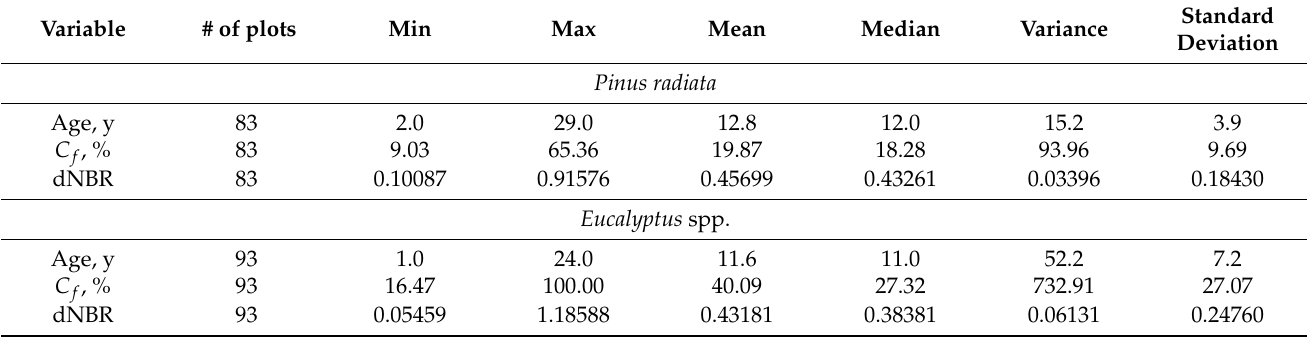
Table 2. Descriptive statistics of the database collected during the fire seasons in